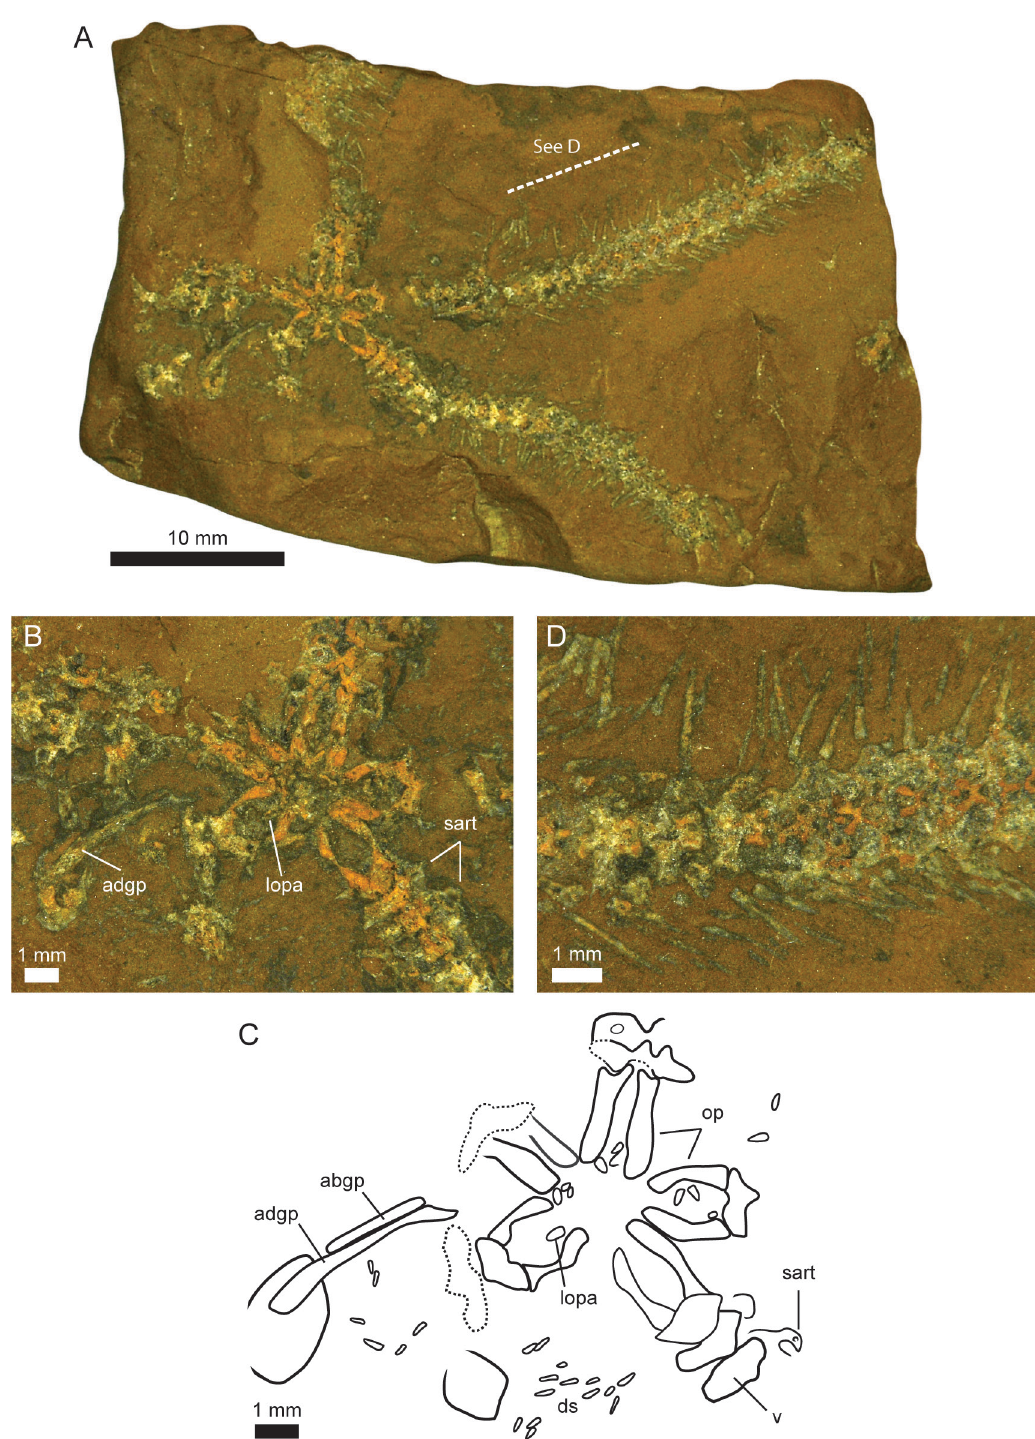
Fig. 4. Ophiogaleus sp. PMO 217.899a. A . Specimen preserving the ventral side of the disc area, two nearly complete arms and proximal area of a third arm. B . Detail view of the disc area. C . Drawing detail of the area shown in B. D . Detail view of a proximal section of arm. Abbreviations: abgp = abradial genital plate; adgp = adradial genital plate; ds = disc spine; lopa = lateral oral papillae; op = oral plate; sart = spine articulation; v =